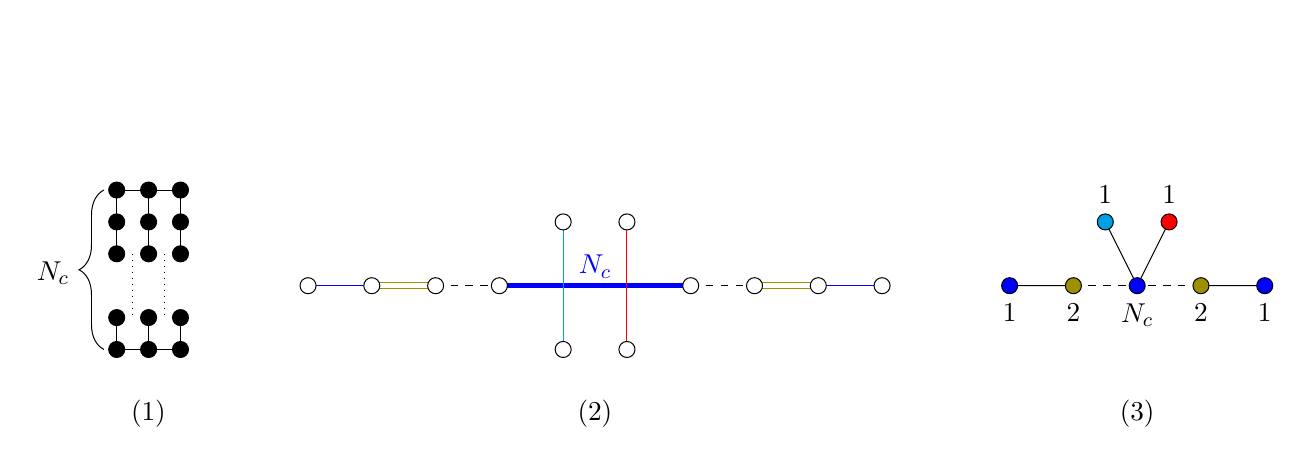
Figure 16 . (1) Toric Diagram representing SQCD with N f = 2 N c indicating the Higgs Branch (3) magnetic Quiver whose 3d Coulomb Branch is the Higgs Branch of our SQCD.